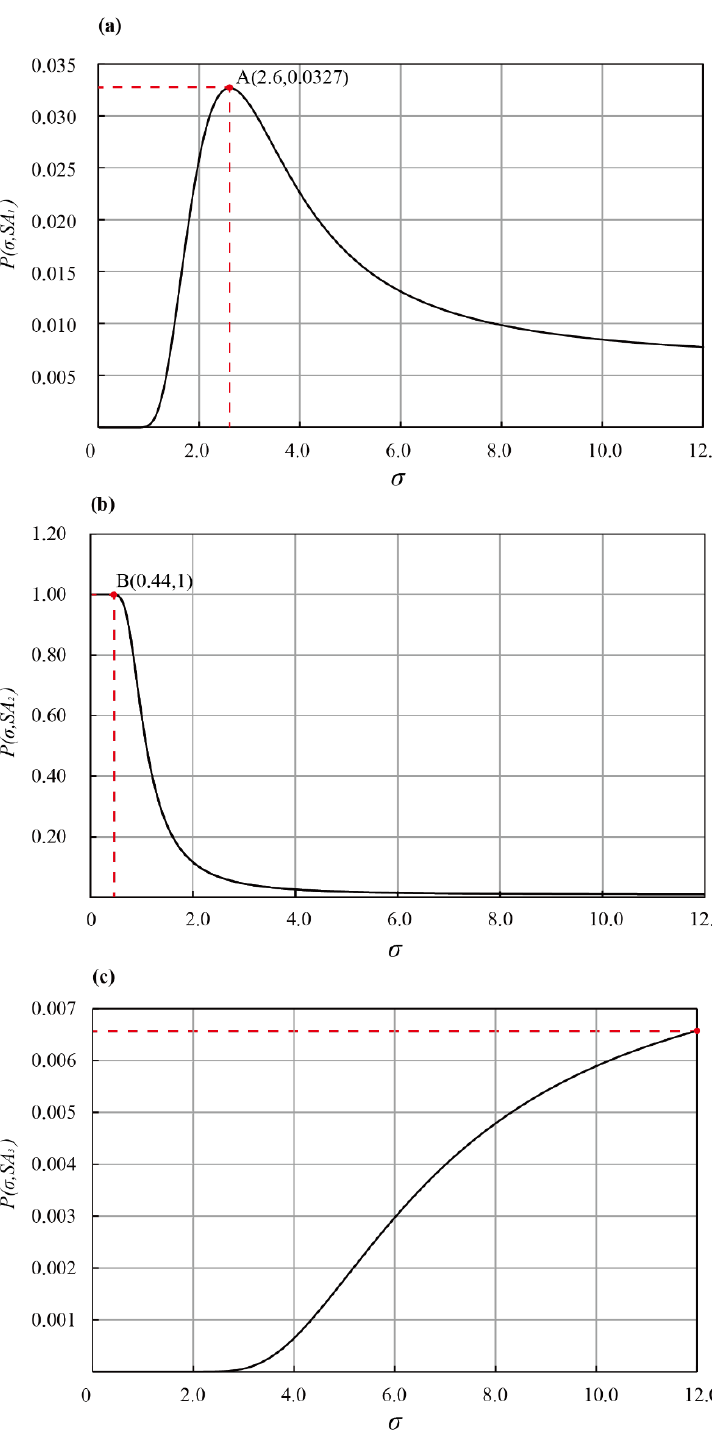
Figure 3. The relationship between σ and the probability of the angle sorting result P ( σ , AS n ) . ( a ) When the angle sorting AS 1 is wrong, the relationship between the σ and the probability of the angle sort result P ( σ , AS 1 ) is AS 1 = ( 26 ◦ ,22 ◦ ,24 ◦ ,28 ◦ ,30 ◦ ) . ( b ) When the angle sort AS 2 is completely correct, the relationship between the σ and the probability of the angle sort result P ( σ , AS 2 ) is, AS 2 = ( 22 ◦ ,24 ◦ ,26 ◦ ,28 ◦ ,30 ◦ ) . ( c ) When the angle sort AS 3 is wrong, treating the larger angle as the smaller angle, the relationship between σ and the probability of the angle sorting result P ( σ , AS 3 ) . The relationship between σ and the probability of the angle sorting result P ( σ , AS 3 ) is AS 3 = ( 28 ◦ ,30 ◦ ,26 ◦ ,24 ◦ ,22 ◦ ) .